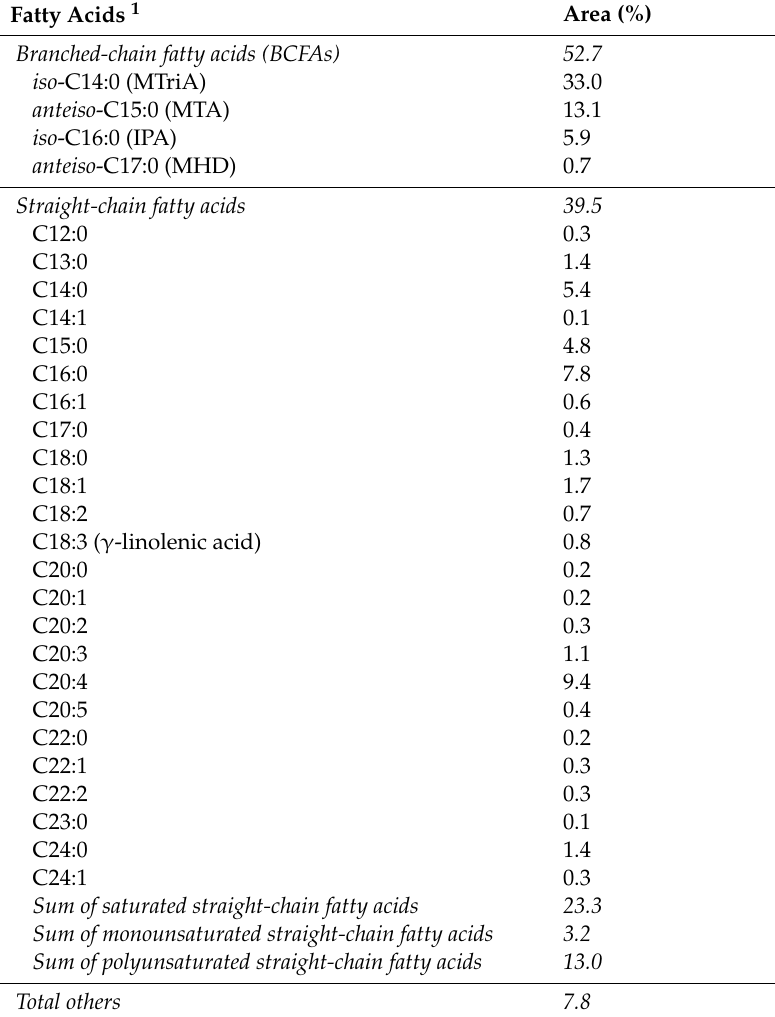
Table 1. Fatty acid composition of the Conidiobolus heterosporus lipid